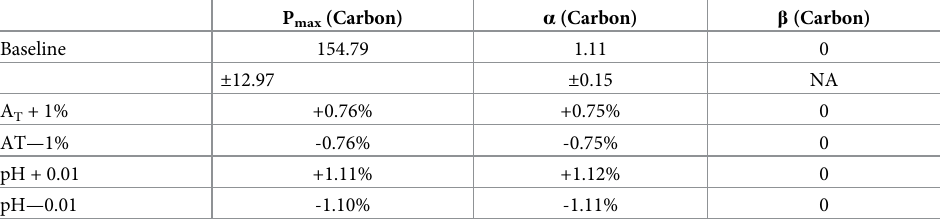
Table 2. P vs. E parameters with data fitted using equations from Platt et al. [22], with sensitivity test results.